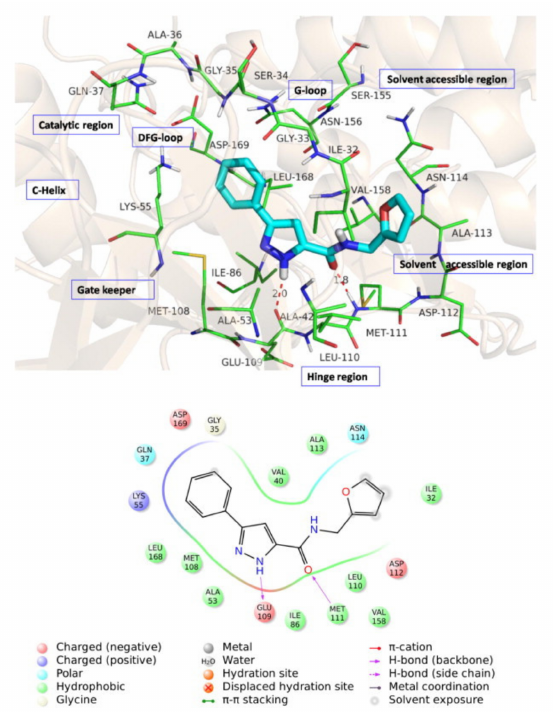
Figure 54. Docking pose and putative binding interactions of compound 46 with JNK-1 kinase crystal structure